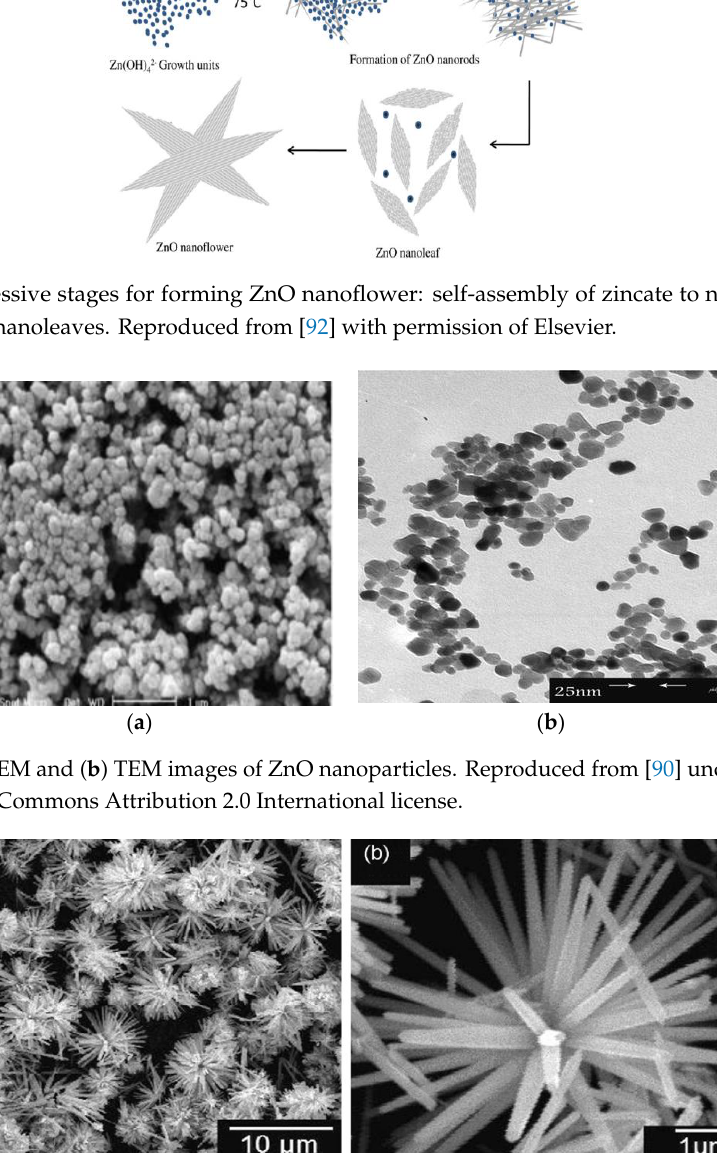
Figure 11. ( a ) SEM image of ZnO nanoflowers prepared by co-precipitation process. ( b ) A magnified SEM image of ZnO nanoflowers. Reproduced from [89] with permission of